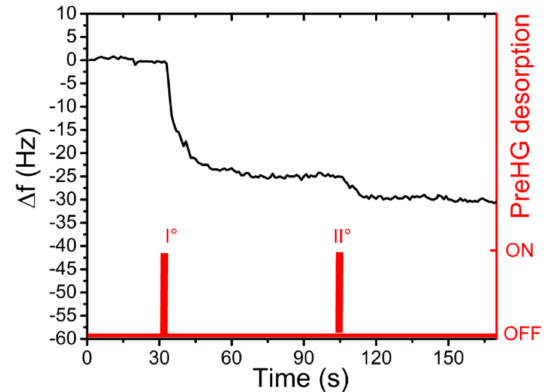
Figure 12. QCM frequency shift, after a preconcentrator exposition of 30 min, at a concentration of 30 µ g/m 3 of Hg 0